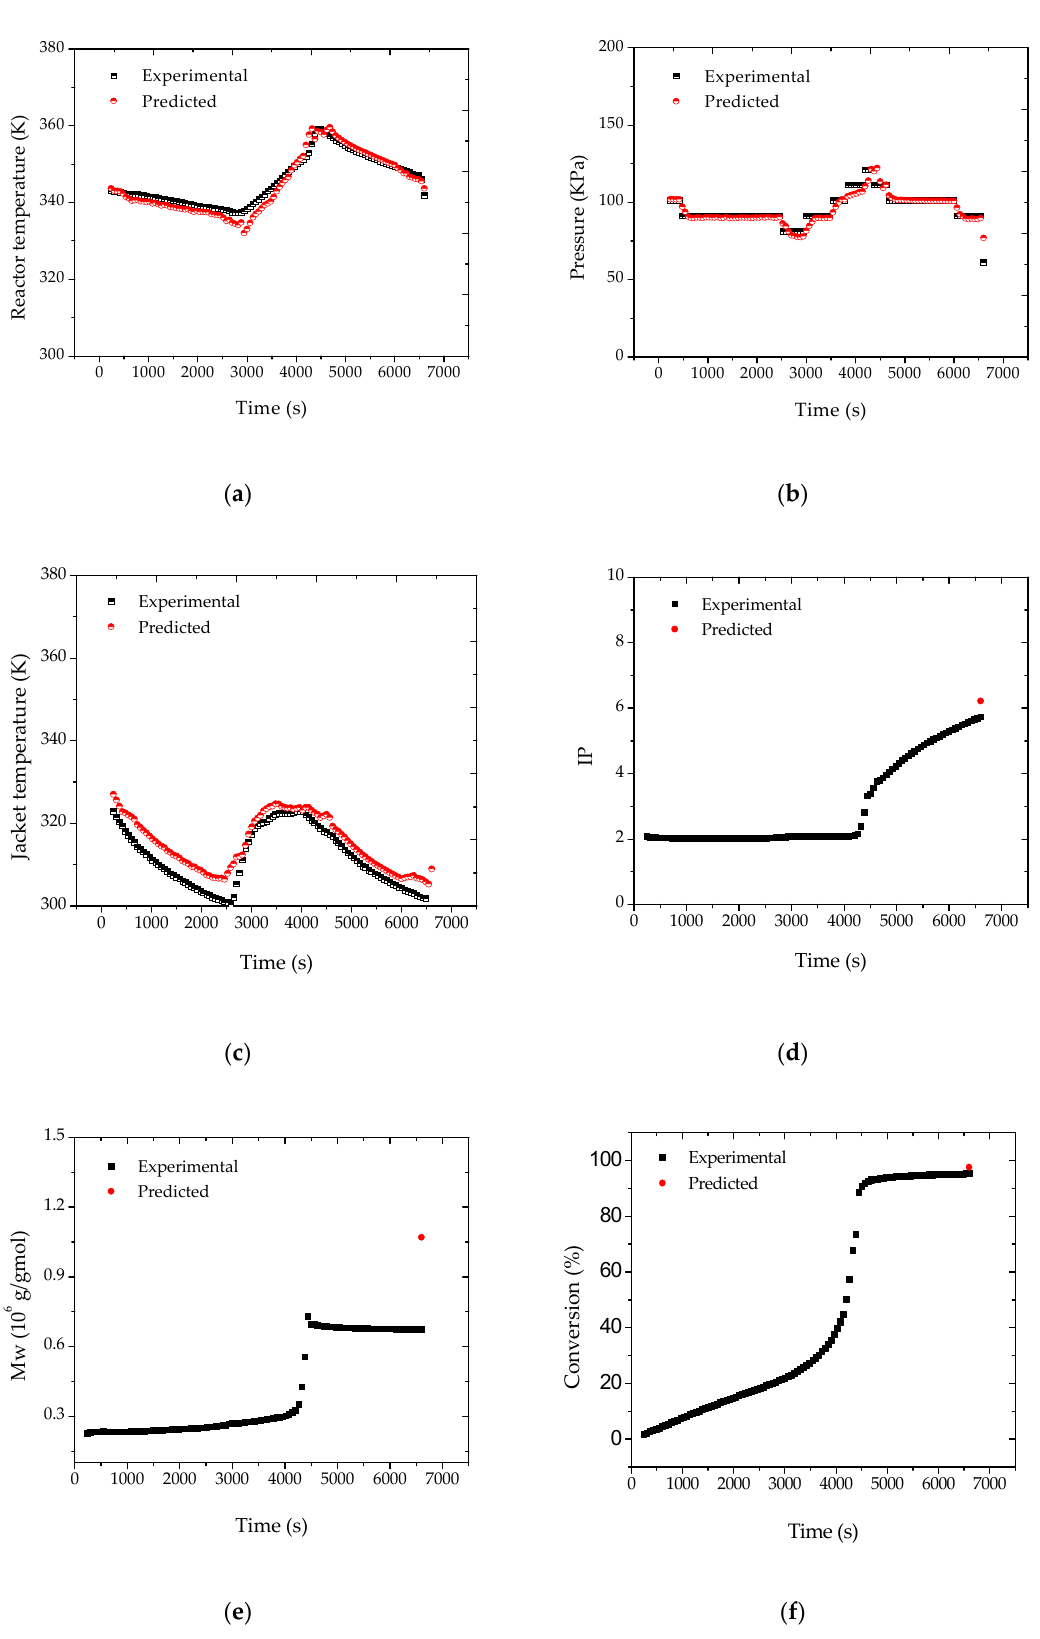
Figure 6. Reconciled ( a ) reactor temperature; ( b ) reactor pressure; ( c ) jacket temperature; ( d ) IP; ( e ) Mw; ( f ) conversion profiles for reaction R3, considering the formation of fresh monomer droplets.